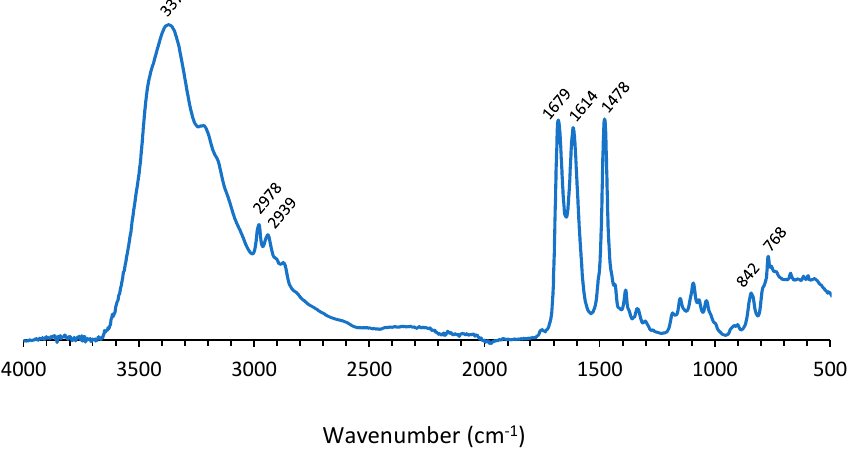
Figure 3. IR spectrum of degradation product extracted out of the water phase upon degradation of PU coating.